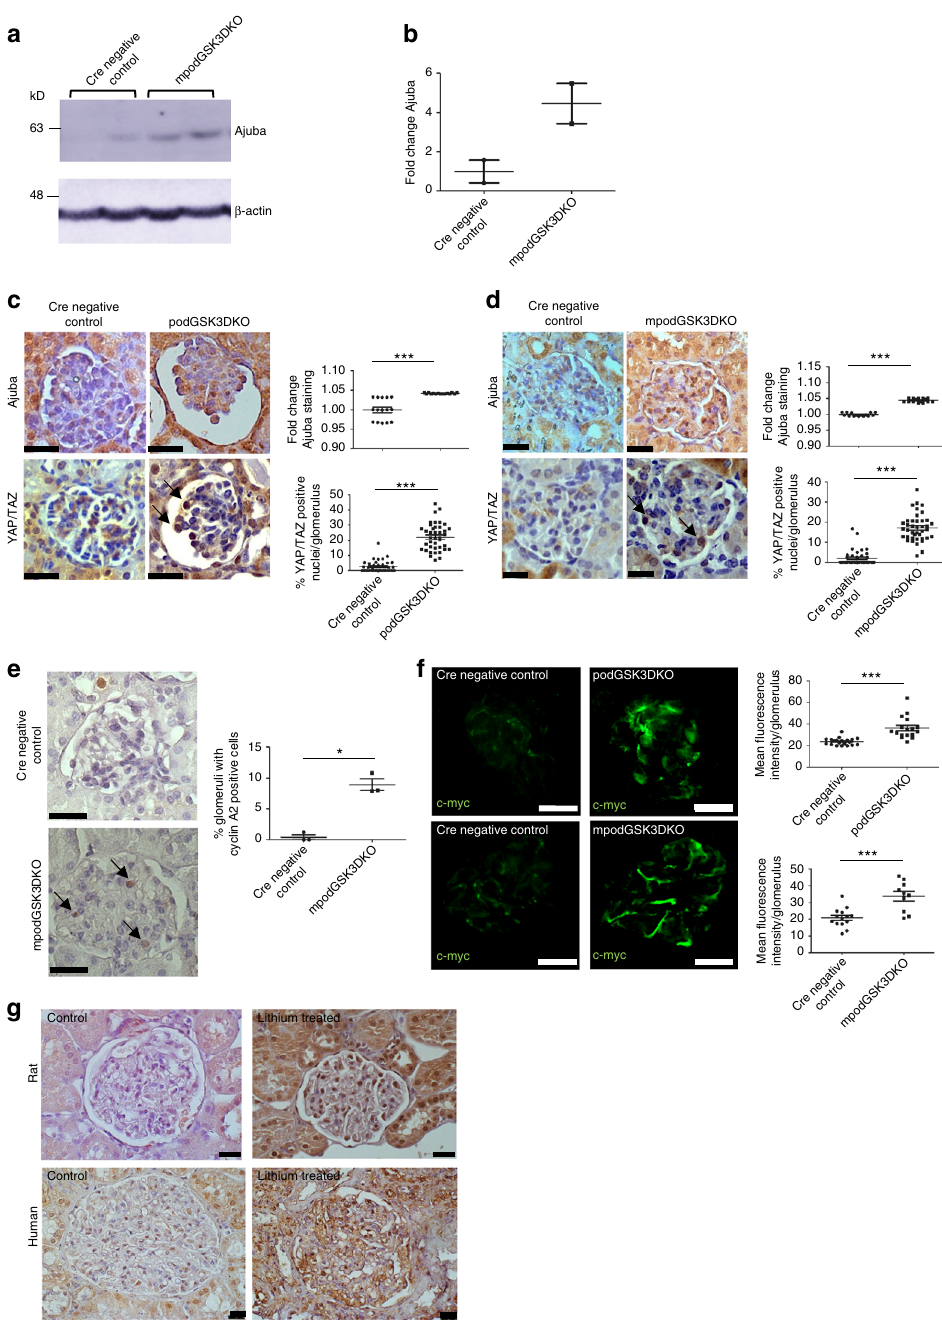
Fig. 7 Hippo signalling is disrupted in GSK3 de fi cient podocytes in vivo. a , b Western blot ( a ) and quanti fi cation ( b ) of glomeruli isolated from mpodGSK3DKO and littermate control mice showing increased expression of Ajuba, n = 2 mice per group. c , d Immunohistochemistry showing increased Ajuba (top panels) and YAP/TAZ nuclear translocation (arrowed, bottom panels) in the podocytes of podGSK3DKO ( c ) and mpodGSK3DKO ( d ) mice. Representative immunohistochemistry and quanti fi cation shown (>5 glomeruli per mouse analysed, 3 mice per group, ANOVA *** p < 0.001. Scale bar = 25 μ m). e Immunohistochemistry showing an increase in the number of cells positive for the YAP/TAZ TEAD target Cyclin A2. Three mice from each group analysed, t test * p < 0.5. f Immuno fl uorescence staining showing increased expression of c-myc in podGSK3DKO and mpodGSK3DKO mice. Three mice analysed per group, t test *** p < 0.001. Scale bar = 50 μ m. g Representative immunohistochemistry using an anti-Ajuba antibody in a glomerulus from a rat given high dose lithium for 6 months and in a biopsy from a patient on long-term lithium therapy. Ajuba expression is increased with lithium treatment relative to control tissue. Scale bar = 25 μ m. Data are presented as the mean ± SEM